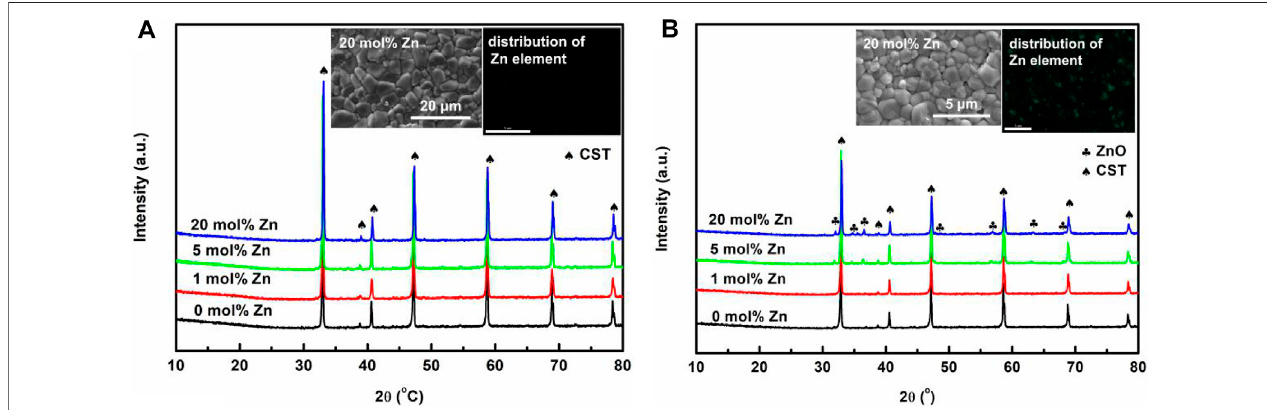
FIGURE1| XRDpatternsforCST-ZnO ceramics prepared via (A) process route 1and (B) process route 2,and theinsets aretheSEMimages and thedistribution of the Zn element for CST-20 mol% ZnO ceramics.